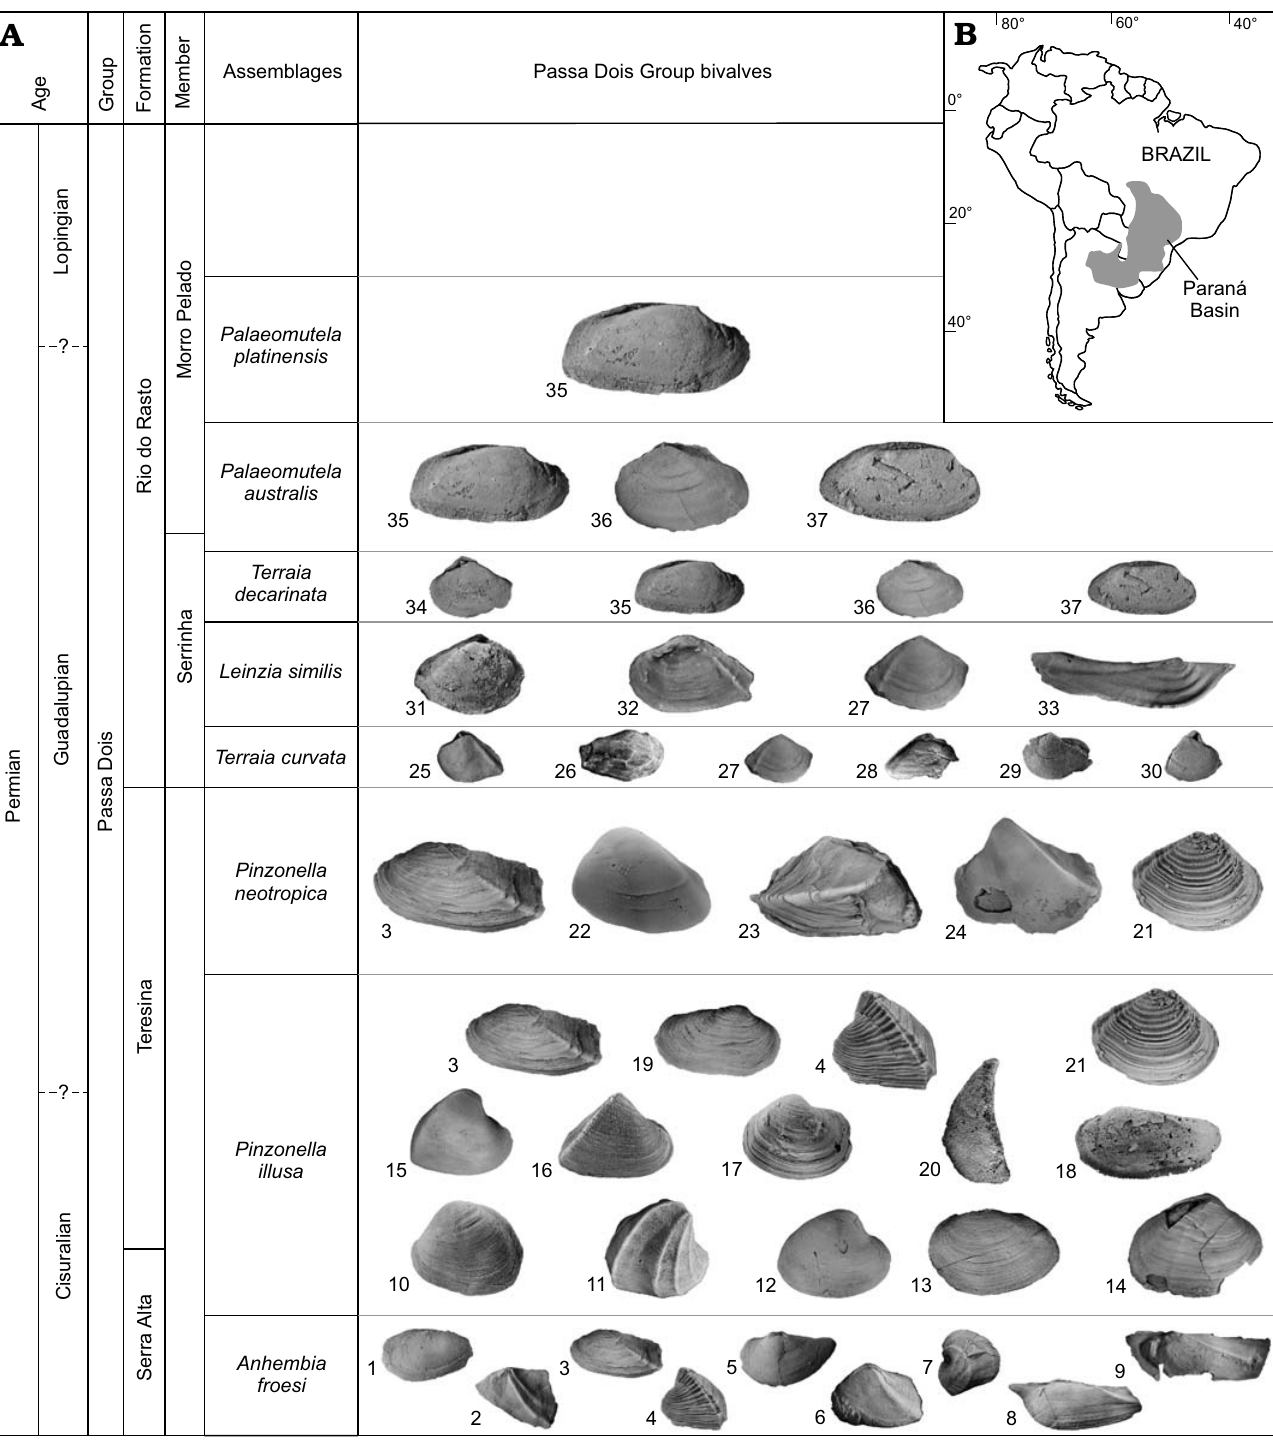
Fig. 1. Chart showing the main bivalve assemblages and constituent species recorded in the Permian Passa Dois Group, except the Irati Formation ( A ), and location of Paraná Basin, Brazil ( B ). Species composition (not to scale): 1, Kidodia cf. K . stockleyi ; 2, Barbosaia angulata ; 3, Holdhausiella elon- gata ; 4, Tambaquyra camargoi ; 5, Rioclaroa lefevrei ; 6, Maackia contorta ; 7, Ferrazia simplicicarinata ; 8, Anhembia gigantea ; 9, Anhembia froesi ; 10, Pinzonella illusa ; 11, Ferrazia cardinalis ; 12, Casterella gratiosa ; 13, Angatubia cowperesioides ; 14, Othonella araguaiana , 15, Plesiocyprinella carinata ; 16, Terraia aequilateralis ; 17, Runnegariella fragilis ; 18, Favalia arcuata ; 19, Roxoa corumbataiensis ; 20, Coxesia mezzalirai ; 21, Cowperesia anceps ; 22, Pinzonella neotropica ; 23, Naiadopsis lamellosus ; 24, Jaquesia brasiliensis ; 25, Terraia curvata , 26, Beurlenella elongatella ; 27, Cowperesia emerita ; 28, “ Leinzia ” curta ; 29, Terraia bipleura ; 30, Astartellopsis prosoclina ; 31, Oliveiraia pristina ; 32, Terraia altissima ; 33, Leinzia similis (sensu stricto); 34, Terraia decarinata ; 35, Palaeomutela platinensis ; 36, Relogiincola delicata ; 37, Palaeomutela australis . Data from Mendes (1952), Runnegar and Newell (1971), Simões et al. (1998), Matos et al. (2017), and Guerrini et al.